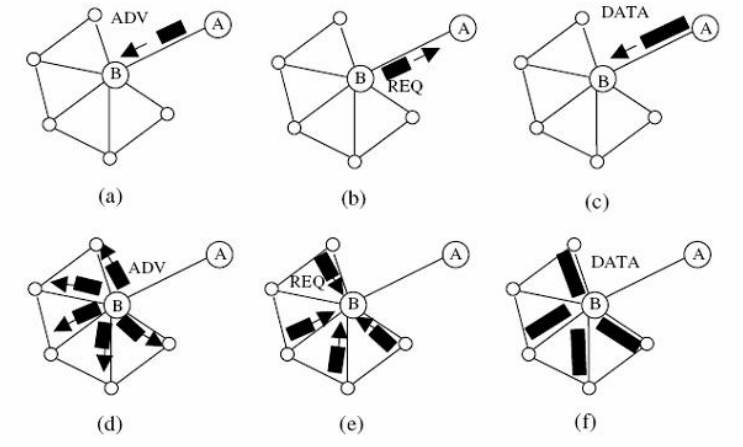
Figure 1. Process of data transmission in